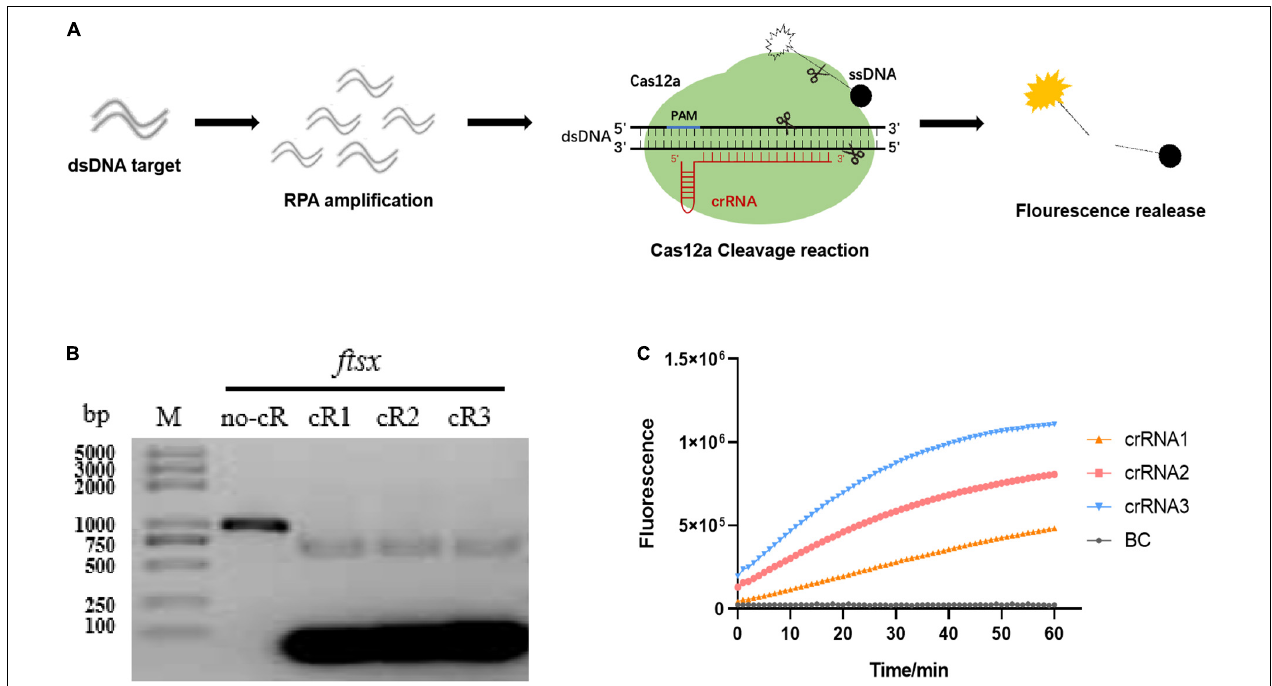
FIGURE 1 | Cas12a-based cleavage reaction combined with recombinase polymerase amplification (RPA) and an FQ-reporter. (A) The schematics of Cas12a-based DNA detection using a FQ-reporter. The starburst indicates fluorophore (e.g., FAM), and the black cycle indicates the quencher of the FQ-reporter. (B) In vitro dsDNA substrate cleavage assay with different crRNAs. M, DNA marker; no-cR, control reaction without crRNA. (C) Detection of the RPA/Cas12a-FQ-reporter assay with different crRNAs. BC, blank control with H 2 O.